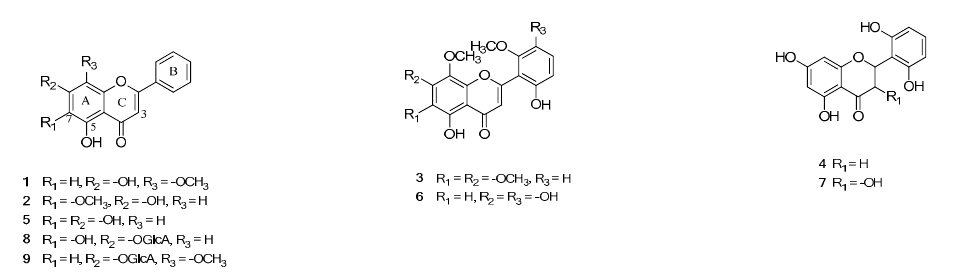
Figure 2. Structure of isolated compounds ( 1 – 9 ) from S. baicalensis .